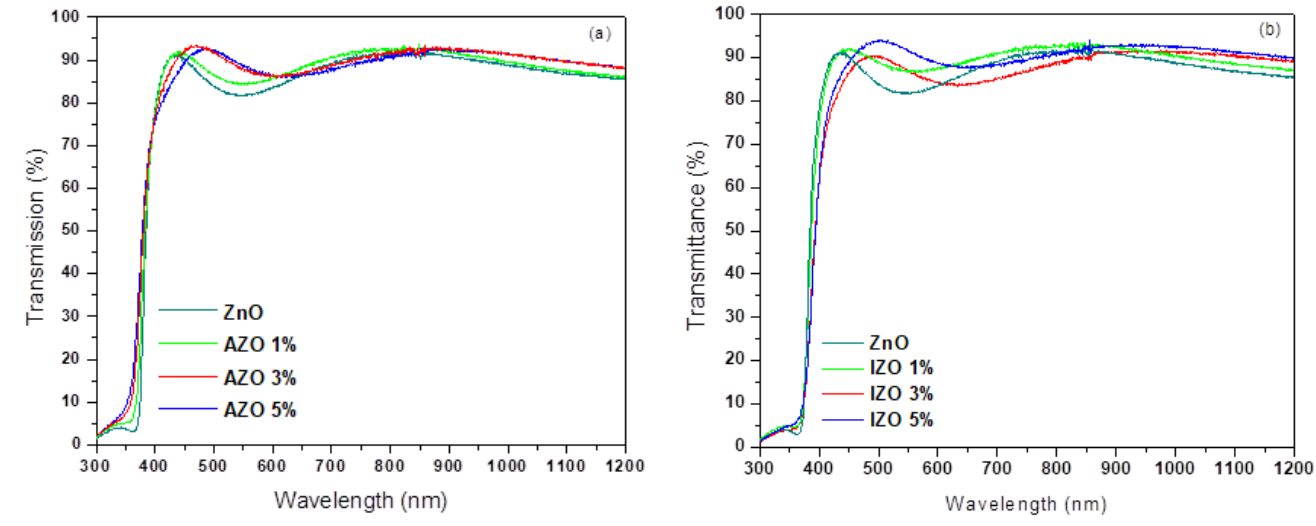
Figure 5. Optical transmittance spectra of undoped ZnO, ( a ) AZO, and ( b ) IZO thin films.